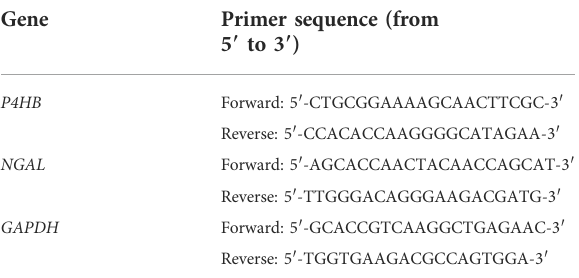
TABLE 1 Quantitative PCR primers used in the